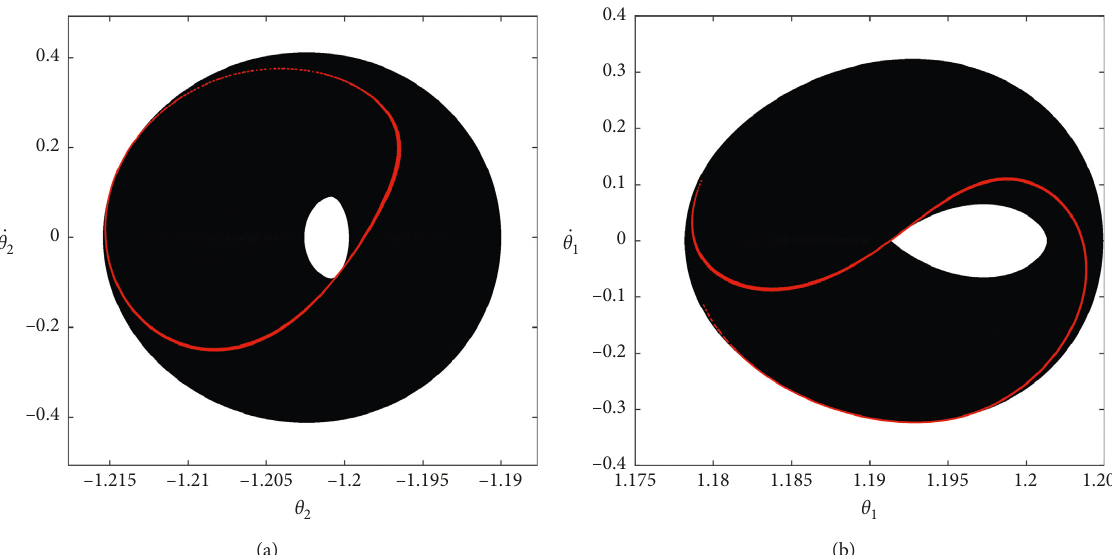
Figure 6: Phase planes (in black) and Poincar´e Map (in red) for nonloaded-free system. (a) Poincar´e section of θ section of θ 2 .